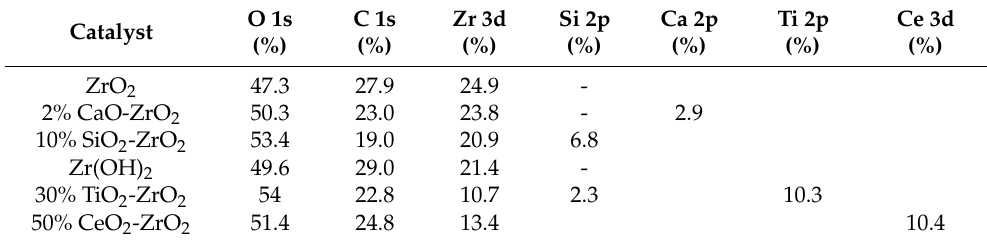
Table 2. Weight percentage (%) of the elements by XPS analysis.